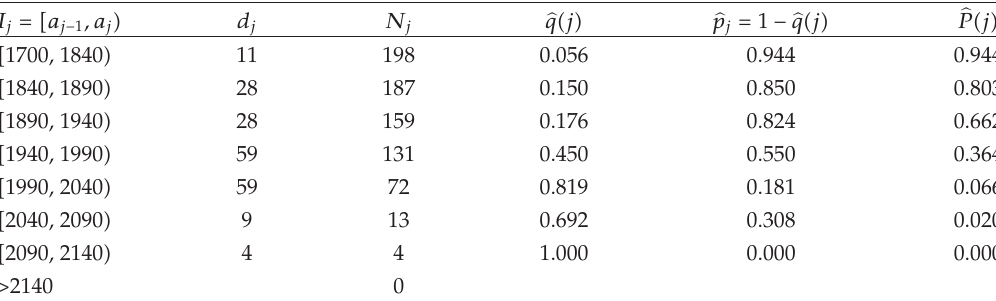
Table 8: Estimation result of the capacity distribution for the shoulder